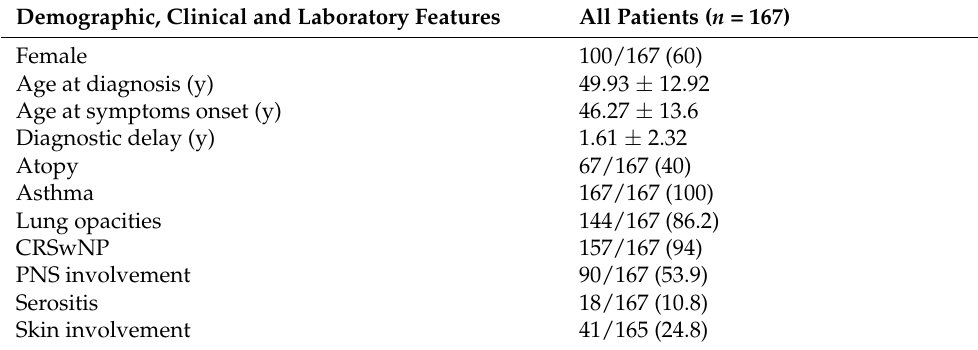
Table 1. Baseline demographic, clinical and laboratory characteristics of the study population. Data are presented as the mean ± standard deviation or number